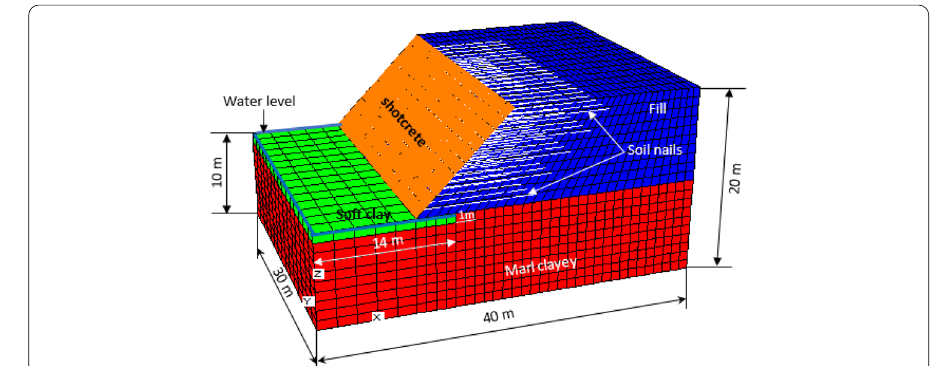
Fig. 6 Finite difference model used in 3D modelling